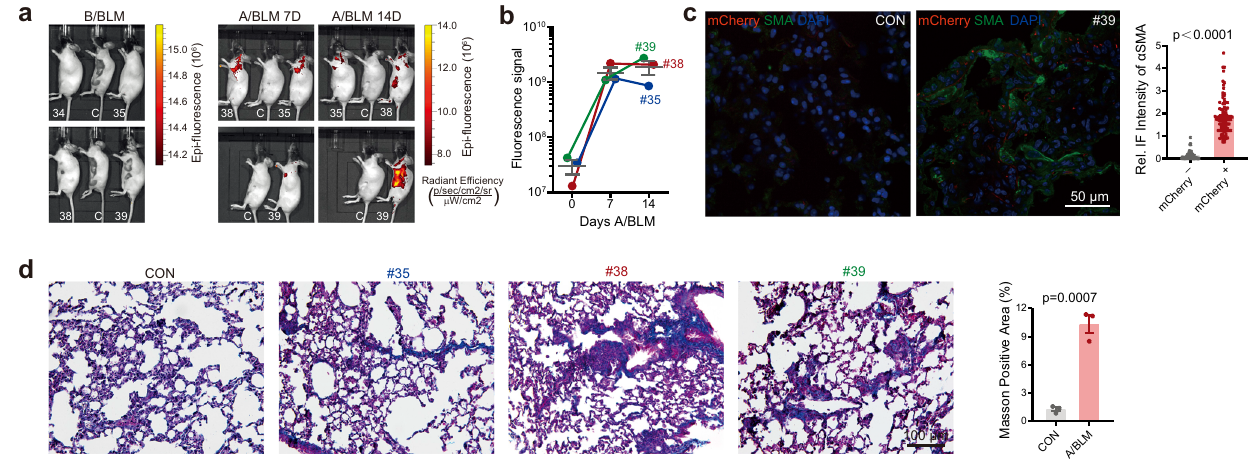
Fig. 6 | GAC signal is exponentially enhanced during pathological senescence. a Representative images showing whole-body GAC signal in Glb1 +/m mice before BLM treatment(B/BLM),and7and 14daysafterBLMtreatment(A/BLM 7D,A/BLM 14D). #35, #38, #39: 16 months, female, Glb1 +/m mice; C: 16 months, female, Glb1 +/+ mice; #34, unrelated mice. b Quanti fi cation of GAC signal in a . n =3 mice. c GAC signal and anti-SMA staining in lung section from Glb1 +/m mice 14 days after treat- ment with BLM and quanti fi cation of signal intensity. Tissues from n =3 mice were